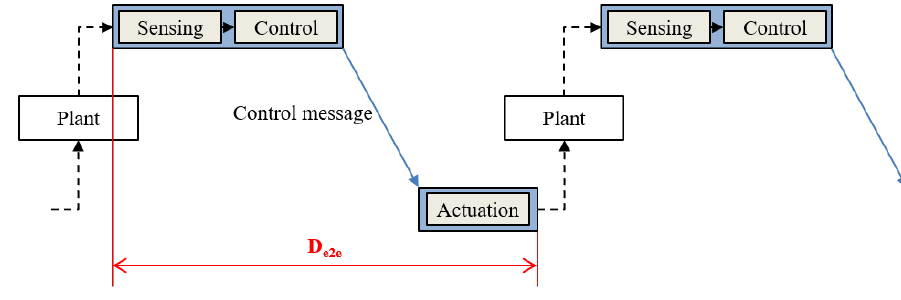
Figure 2. End-to-end delay of control loop.